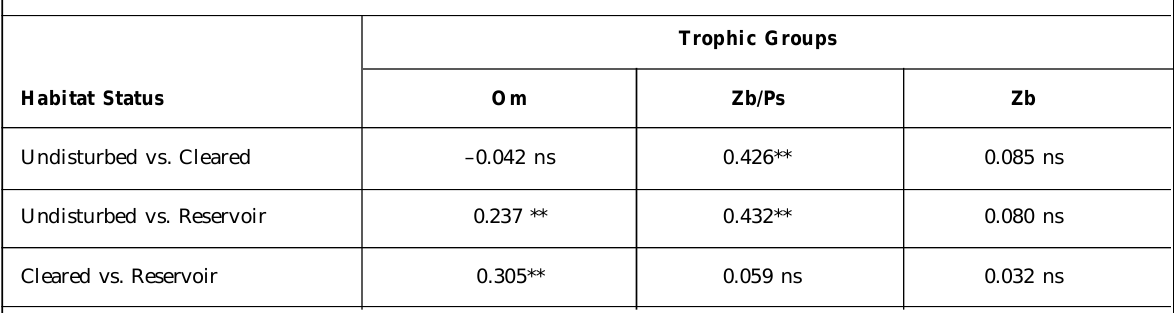
Table 4: Summary of one-way ANOSIM ( R ) of three common trophic groups found in all areas of the creek systems subject to different human